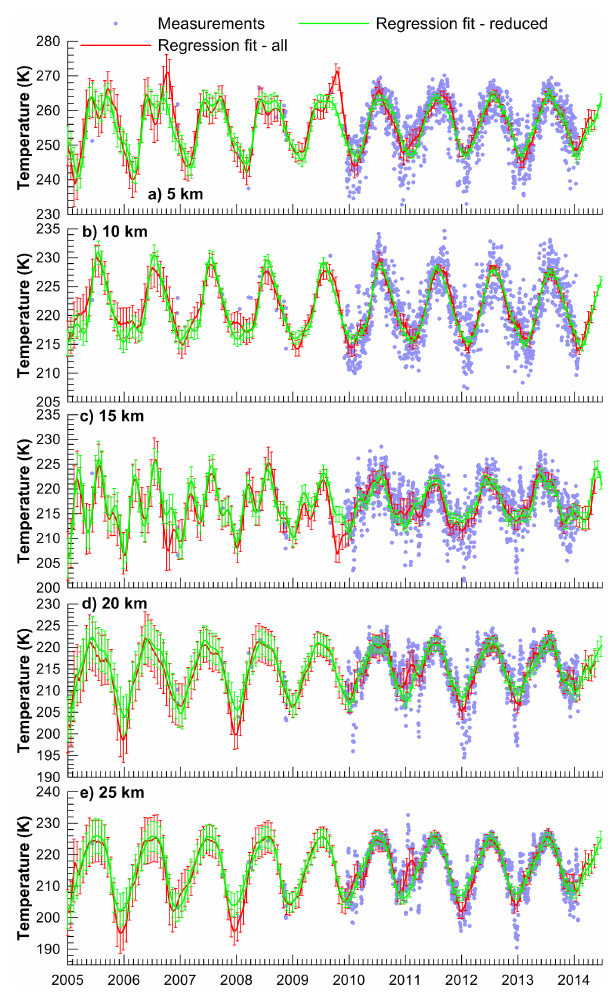
Figure 6. Examples of regression model fits to the 00:00UT mea- surements at five selected altitude levels spaced 5km apart. 1 σ un- certainties are shown as error bars on the regression model fits. Be- cause the measurement random uncertainties are small i.e. ∼ 0.1K, they are not